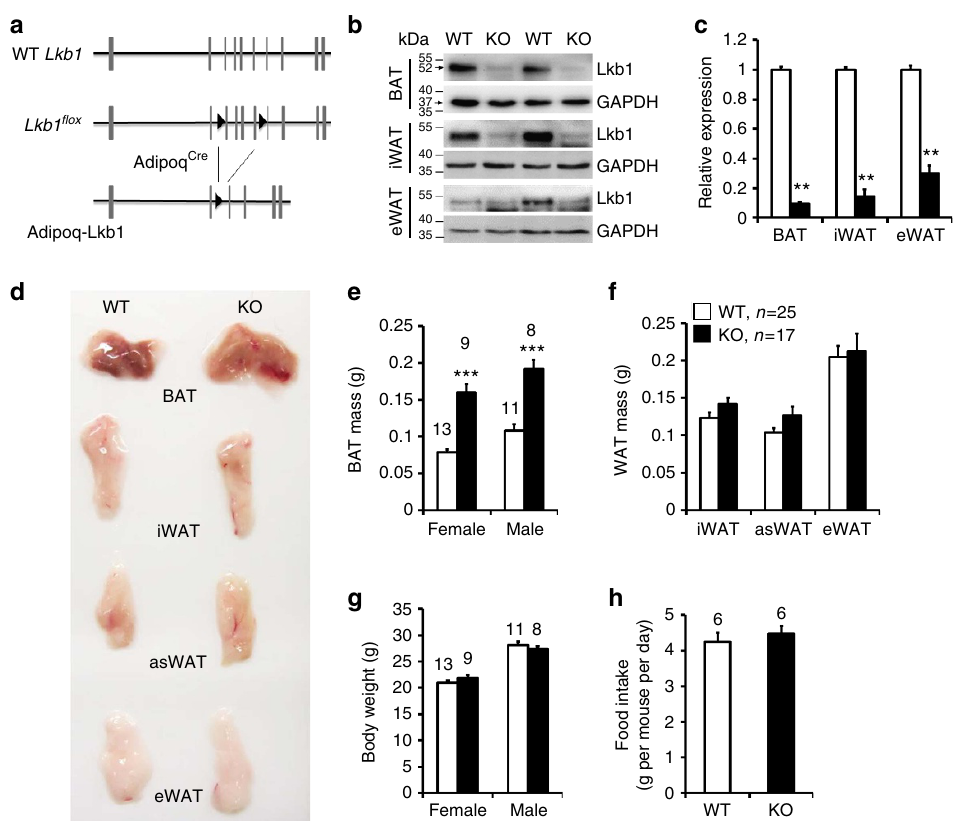
Figure 1 | Adipoq-Cre -mediated deletion of Lkb1 increases the mass of BAT but not WAT. ( a ) Targeting strategy for adipocyte-specific deletion of Lkb1 . Vertical lines represent exons and triangles represent LoxP. ( b , c ) Efficient reduction of Lkb1 protein ( b ) and mRNA ( c , n ¼ 4) levels in BATand WATdepots of the Adipoq-Lkb1 KO mice. ( d ) Representative images of BATand WATdepots showing specific enlargement of Lkb1 KO BAT. ( e – h ) Lkb1 deletion increases the weights of BAT ( e ) without affecting WAT ( f , WT n ¼ 25, KO n ¼ 17) and overall body weight ( g ), or food intake ( h ). Numbers above the bars are animals (2–3 months old) analysed. Error bars, s.e.m., ** P o 0.01, *** P o 0.001, two-tailed Student’s t